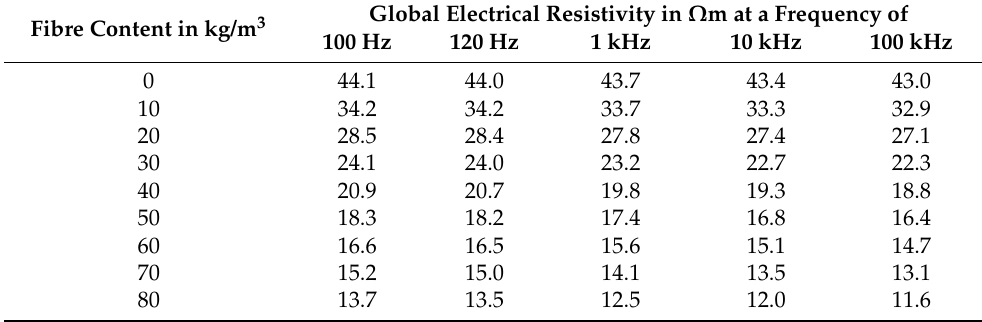
Table A10. Results of the resistivity measurements of the basic concrete mixture (32-60-300-00).